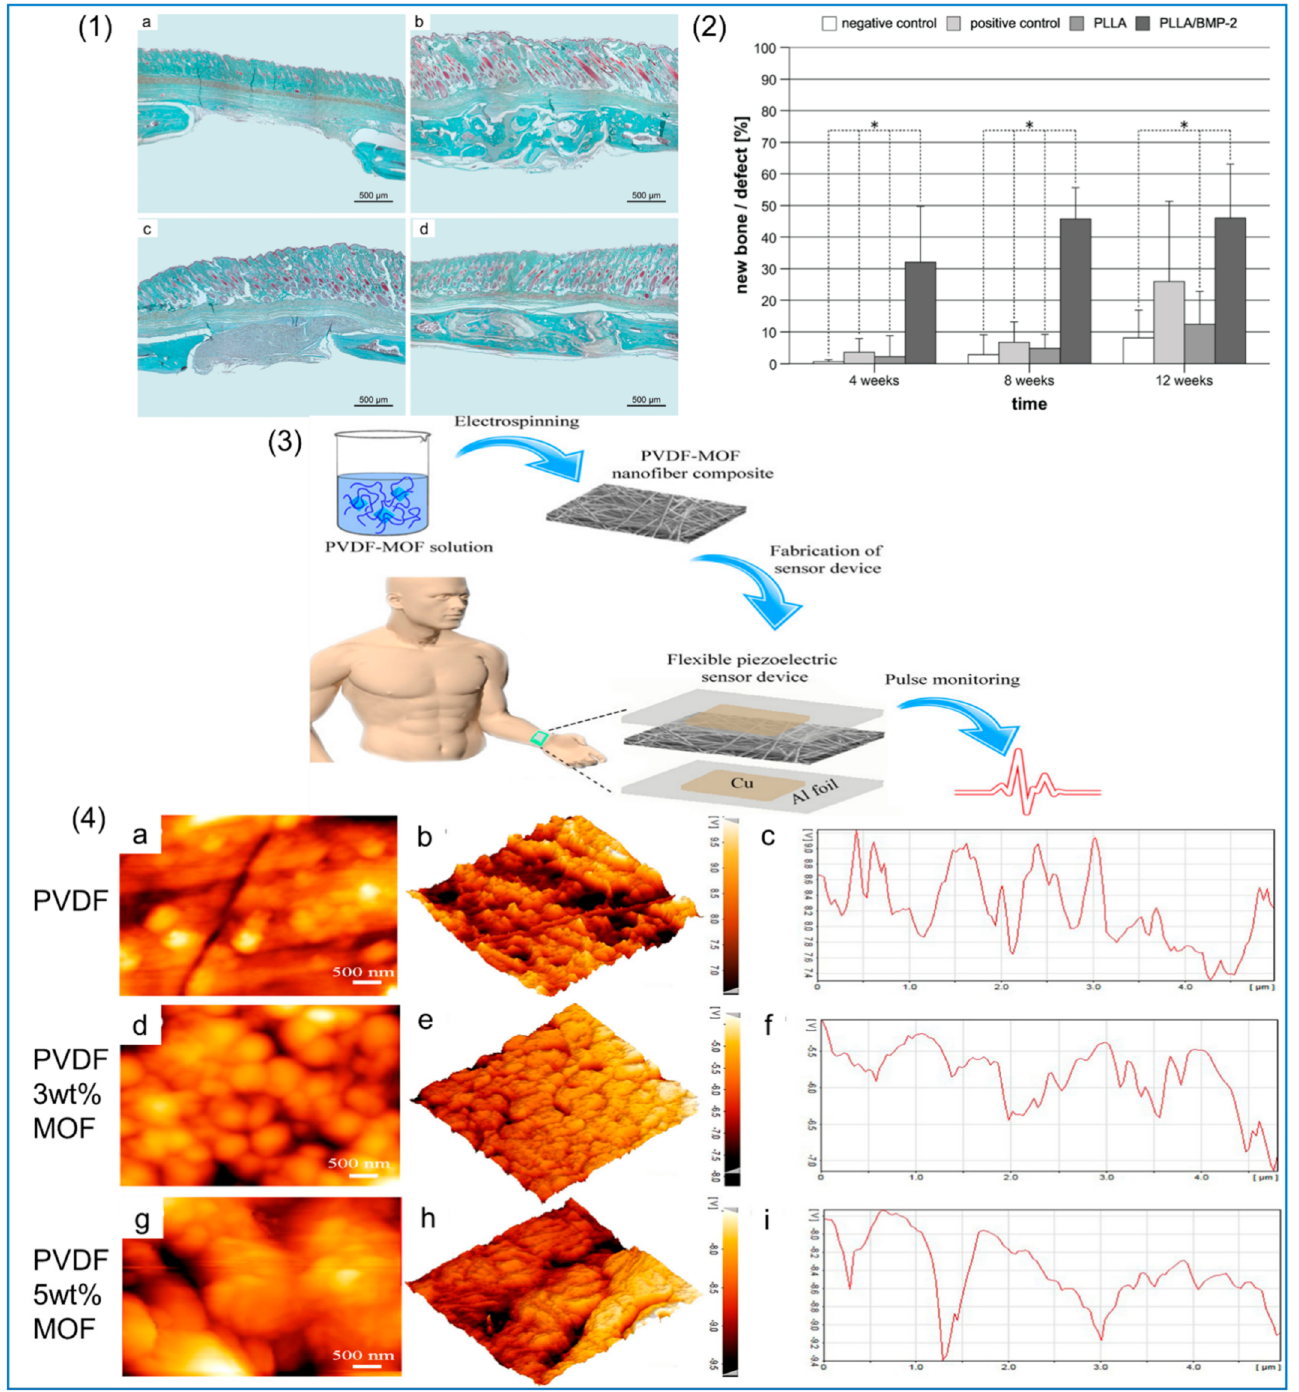
Figure 12. ( 1 ) Histological morphology at week 12: ( a ) negative control. ( b ) Positive control. ( c ) PLLA. ( d ) PLLA/rhBMP-2. Reprinted with permission from Ref. [185], copyright 2011, Public Library of Science. ( 2 ) The relationship between new bone formation and the whole defect area, * p < 0.05. Reprinted with permission from Ref. [185], copyright 2011, Public Library of Science. ( 3 ) Schematic diagram of arterial pulse-sensing device. Reprinted with permission from Ref. [114], copyright 2020, American Chemical Society. ( 4 ) Surface characteristics and piezoelectric response of PVDF NFs. ( a , d , g ) and ( b , e , h ) atomic force microscopy. ( c , f , i ) Voltage curves showing the piezoelectric response of the NFs. Reprinted with permission from Ref. [114], copyright 2020, American Chemical